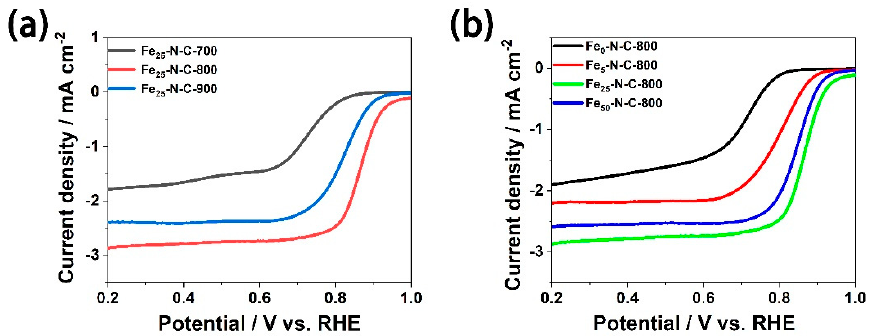
Figure 4. The electrocatalytic behavior in O 2 -saturated 0.1 M KOH (potassium hydroxide solution) at a scan rate of 10 mV s − 1 and a rotation rate of 400 rpm. ( a ) LSVs of Fe 25 -N-C-Y (Y = 700, 800, 900 ◦ C); ( b ) LSVs of Fe X -N-C-800 (X = 0, 5, 25, 50